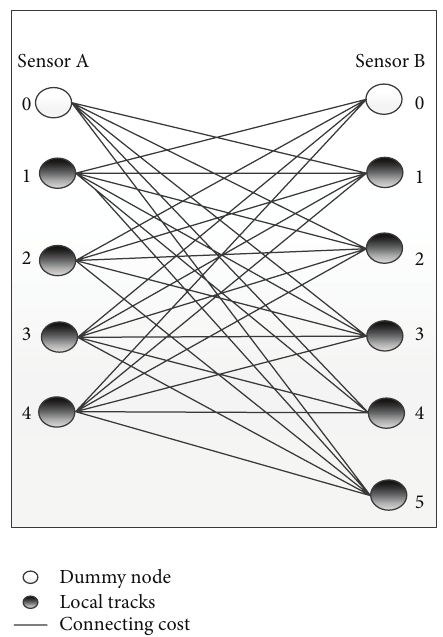
Figure 3: Graphical representation of track association problem.